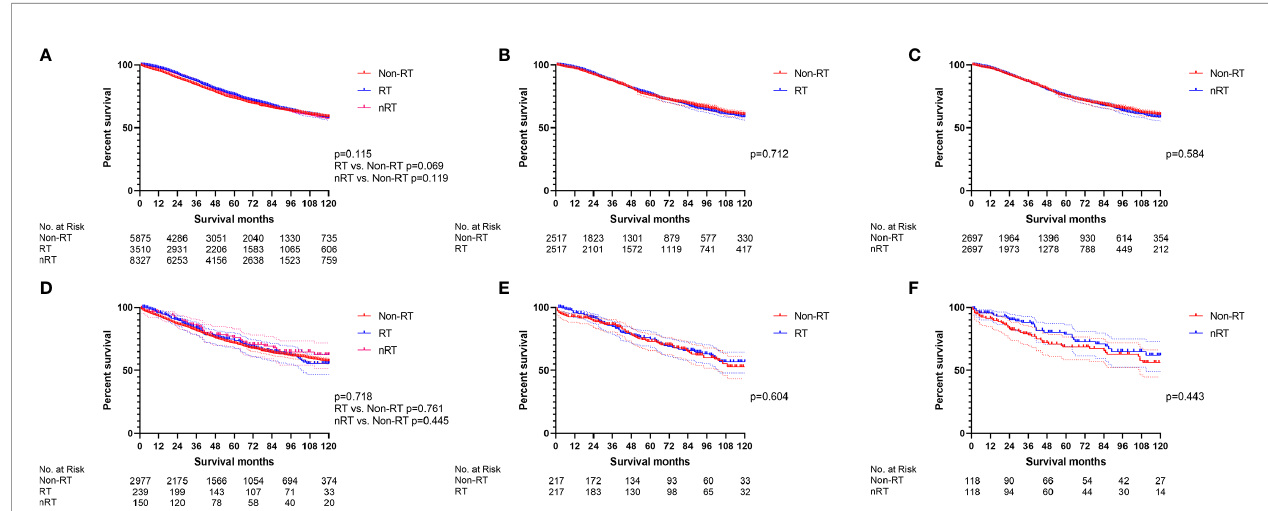
FIGURE 5 | The survival curves were applied to display the effect of radiotherapy in middle-aged stage II/III RC patients. All survival comparisons failed to reach statistical differences. (A) The total middle-aged stage II/III RC patients before PSM. (B) RT vs . non-RT in all middle-aged stage II/III RC patients after PSM. (C) nRT vs . non-RT in all middle-aged stage II/III RC patients after PSM. (D) Middle-aged stage II/III RC patients without chemotherapy before PSM. (E) RT vs . non-RT in middle-aged stage II/III RC patients without chemotherapy after PSM. (F) nRT vs . non-RT in middle-aged stage II/III RC patients without chemotherapy after PSM. (The results of PSM are summarized in Table S4